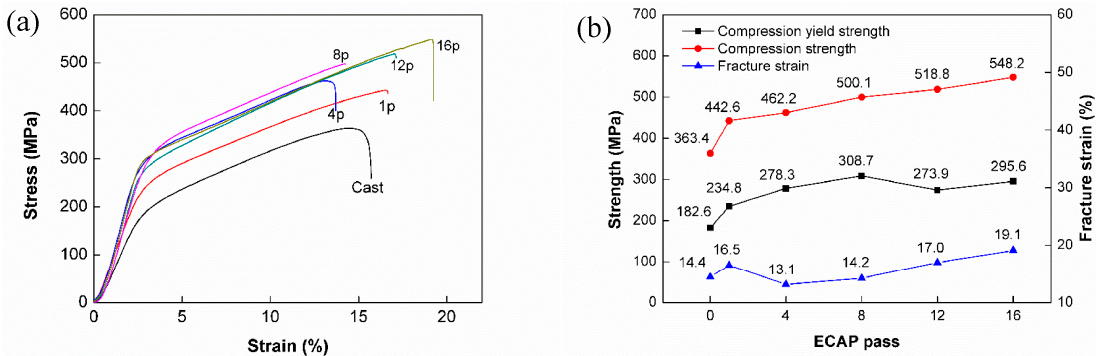
Figure 9. Mechanical properties of cast and ECAP alloys: ( a ) Typical compression engineering stress–strain curves; ( b ) variations of compression yield strength, compression strength and fracture strain with ECAP passes.